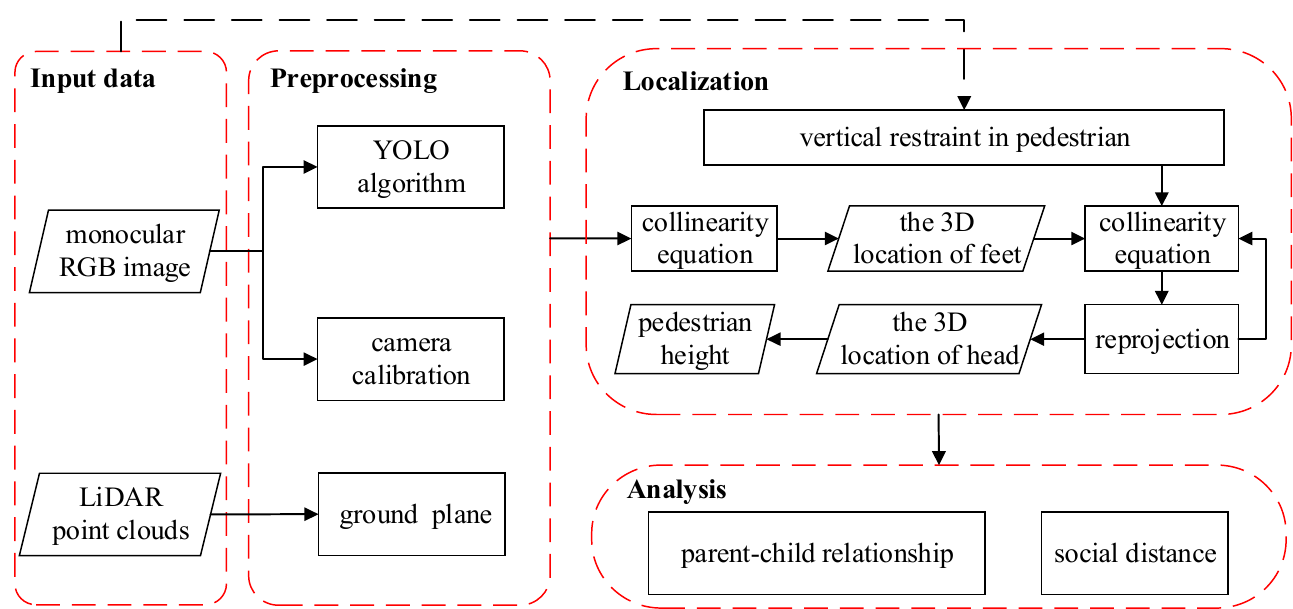
Figure 1. The flowchart of the proposed method.